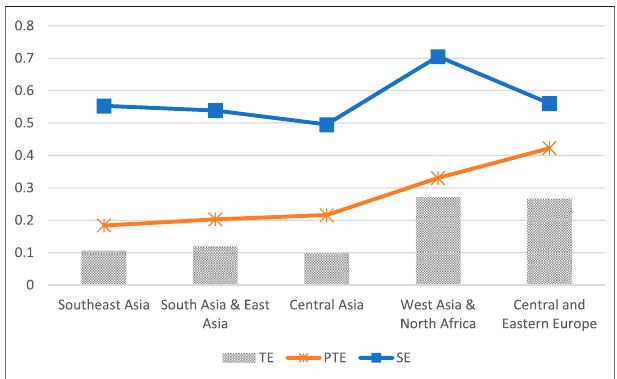
FIGURE 5 | Green investment ef fi ciency and its decomposition